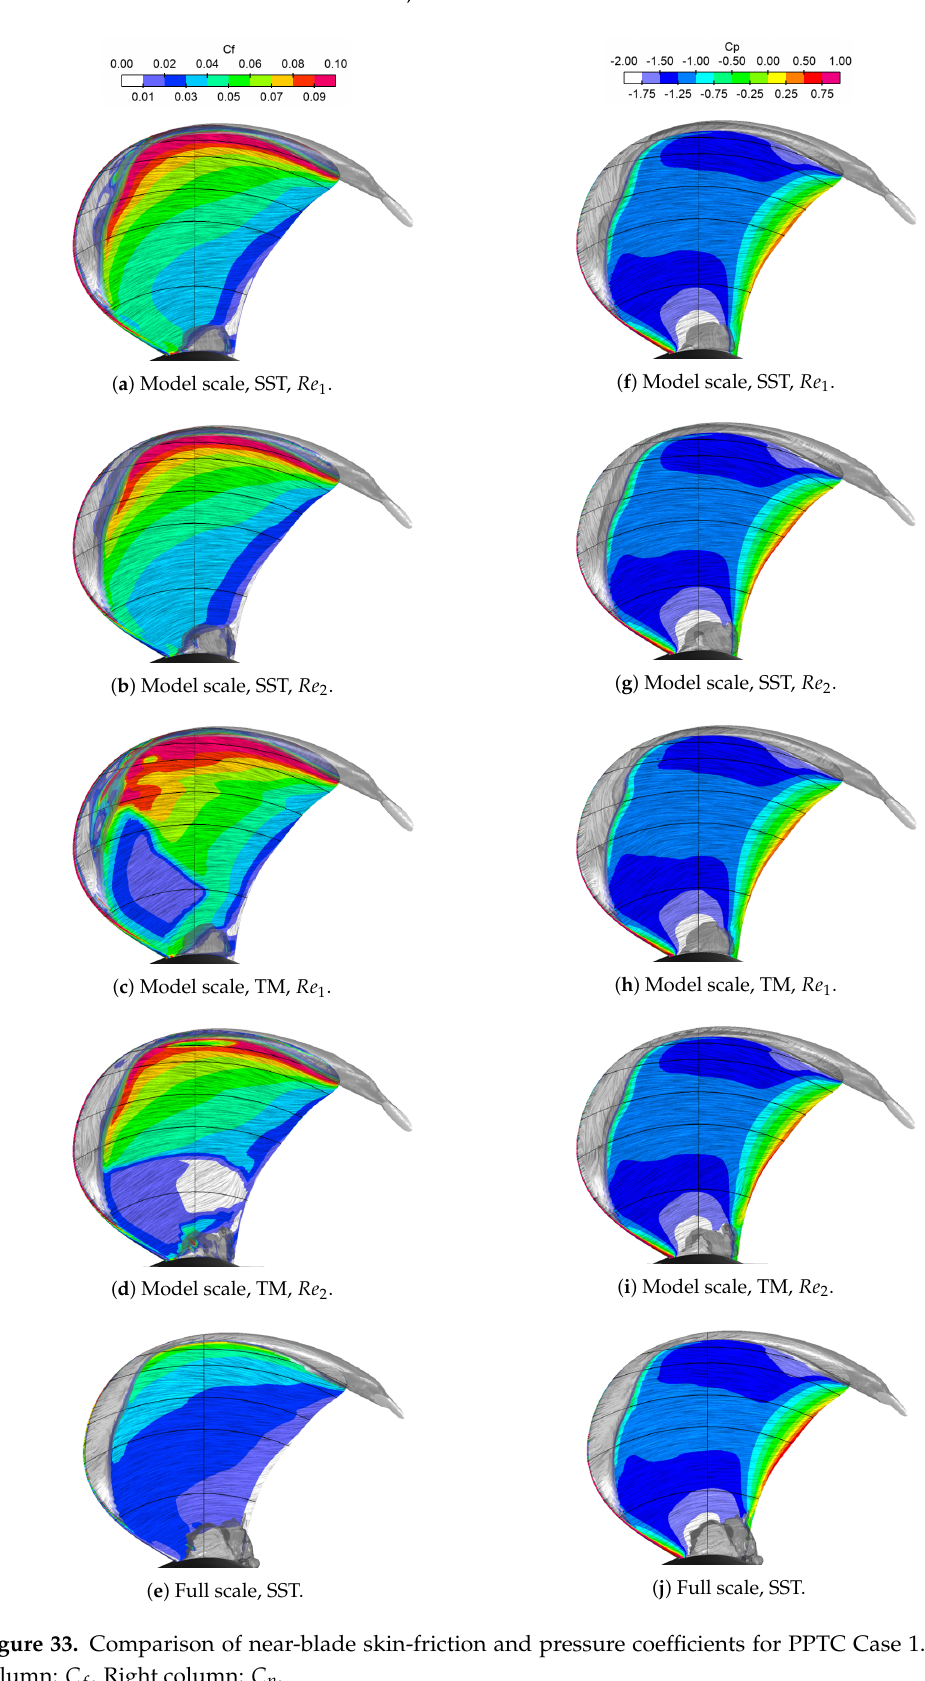
Figure 33. Comparison of near-blade skin-friction and pressure coefficients for PPTC Case 1. Left column: C f . Right column: C p